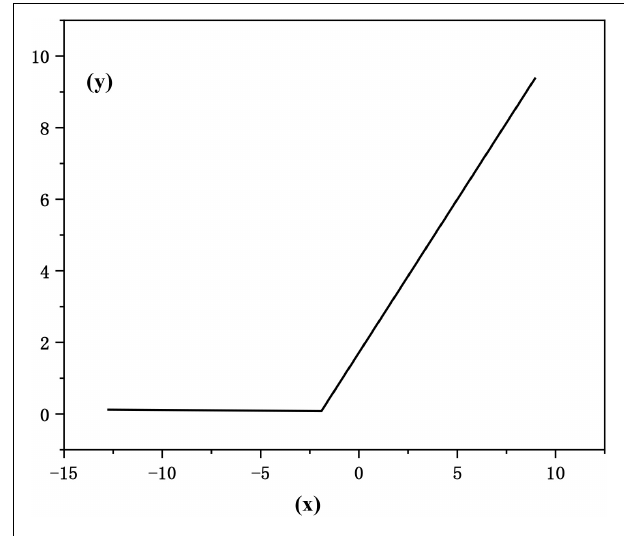
FIGURE 4 | RELU function.